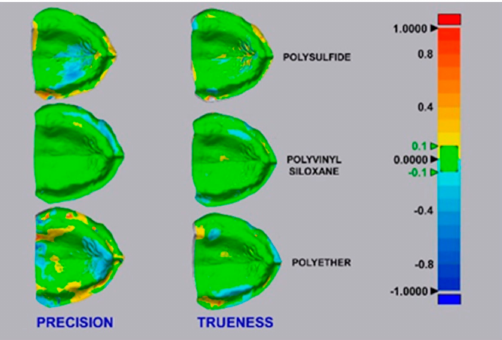
Figure 5. Evaluation of trueness and precision: best superimposition for each group of scans. The green areas indicate a minimum displacement of the digital model compared to the reference data, while red and blue areas indicate an outward and inward displacement between the surfaces,